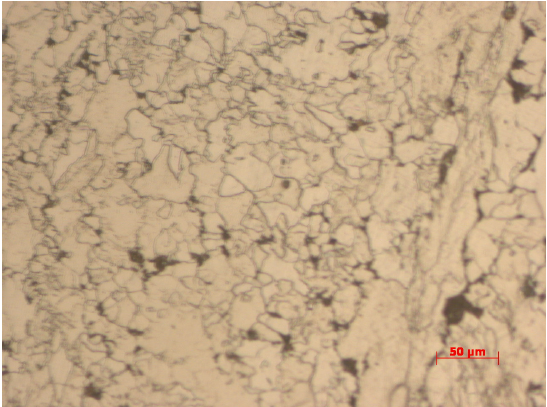
Figure 2. Microstructure after isothermal temperature heat treatment at 1073 K and 4 h followed by water quenching.